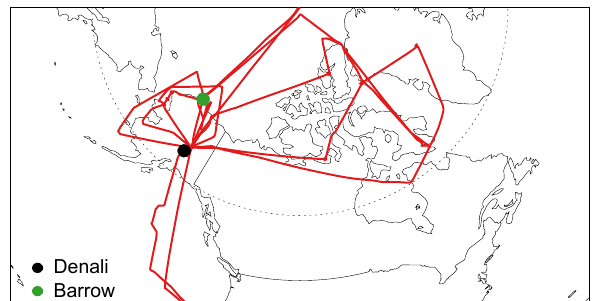
Fig. 4. DC-8 flight tracks during the April 2008 ARCTAS cam- paign (red lines). Long-term monitoring sites for BC at Barrow and Denali are also